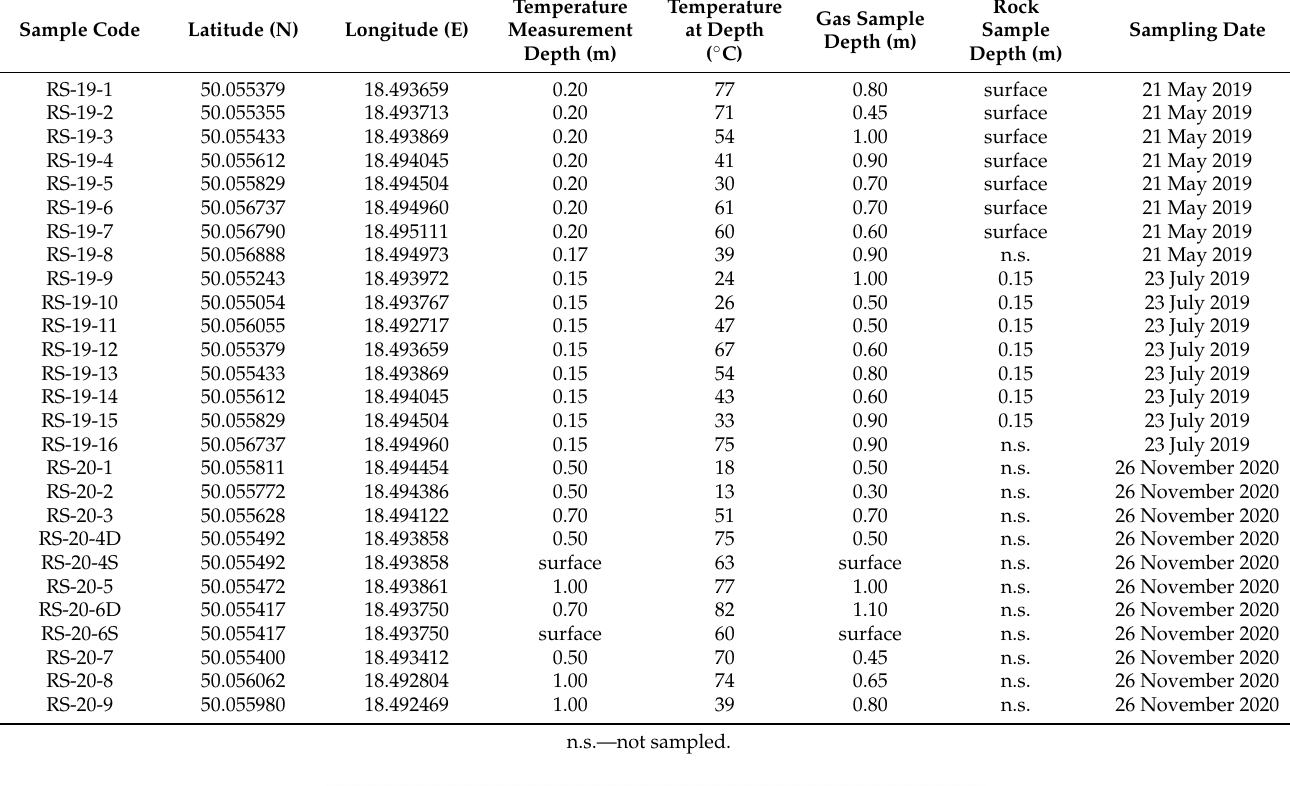
Table 1. General data on gas and rock sampling sites.